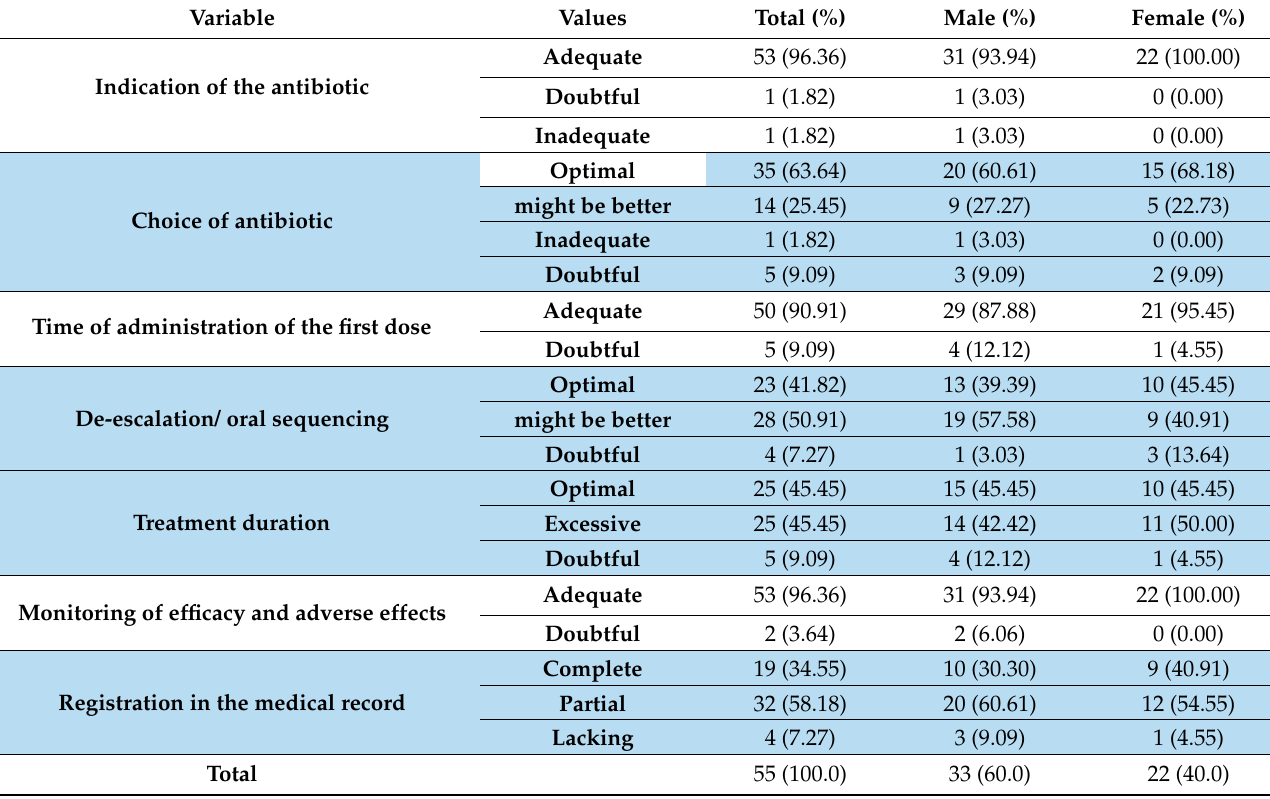
Table 3. Results for treatment process consensus about considered items.